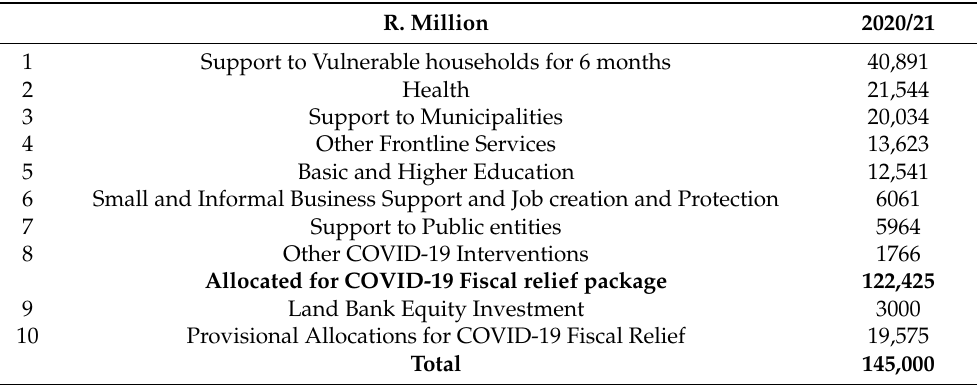
Table 3. Main budget non-interest expenditures.